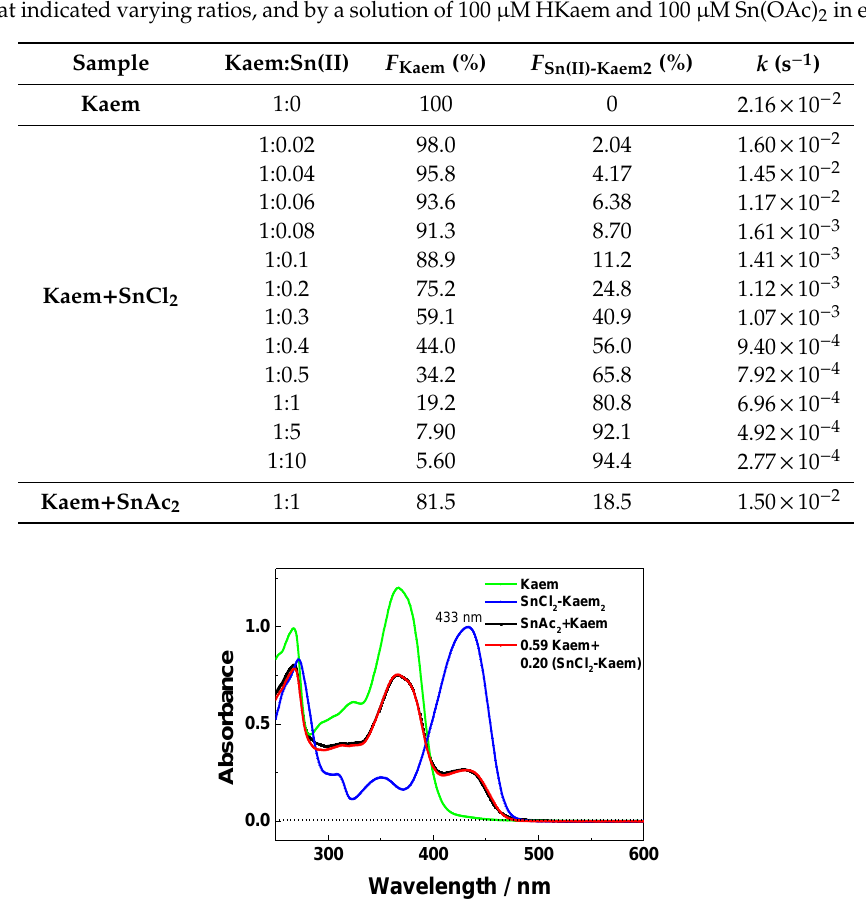
Figure 6. Absorption spectra in ethanol of 50 µ M HKaem alone, 50 µ M HKaem plus 50 µ M Sn(OAc) 2 , 50 µ M HKaem plus 50 µ M SnCl 2 , and the linear combination of spectra of 50 µ M HKaem plus 50 µ M Sn(OAc) 2 , S Kaem + Sn(OAc)2 , using spectrum of HKaem alone, S Kaem , and spectrum of 50 µ M HKaem plus 50 µ M SnCl 2 , S Kaem + SnCl 2 giving the relationship of 0.59 S Kaem + 0.20 S Kaem + SnCl